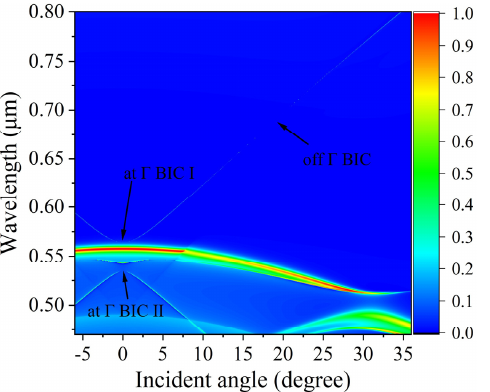
Figure 2. Re fl ectance spectra of the metasurface under p − polarized plane wave. a = 0.336 µm, L 1 = L 2 = 0.2 µm, W 1 = W 2 = 0.1 µm. Figure 2. Reflectance spectra of the metasurface under p-polarized plane wave. a = 0.336 µ m, L 1 = L 2 = 0.2 µ m, W 1 = W 2 = 0.1 µ